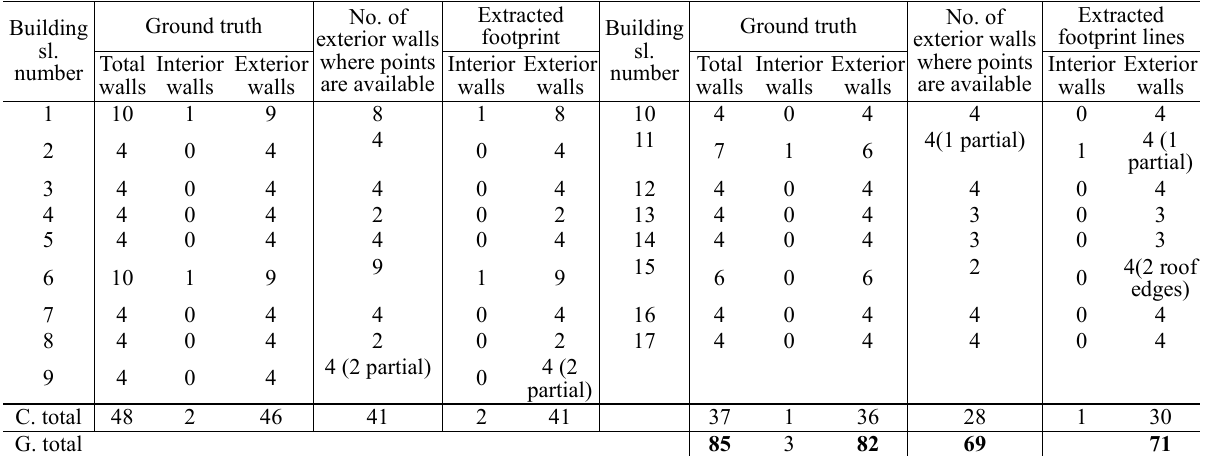
Table 1 . Buildings-wise distribution of extracted footprint-lines, the information relates to Fig. 6i. Column-wise total and Grand total are mentioned as C. total and G. total, respectively. # partial means that # walls are partially scanned. The vertical facades (walls, Fig. 6b) points were projected onto the x - y plane; producing the 2D points in Fig. 6c that appear